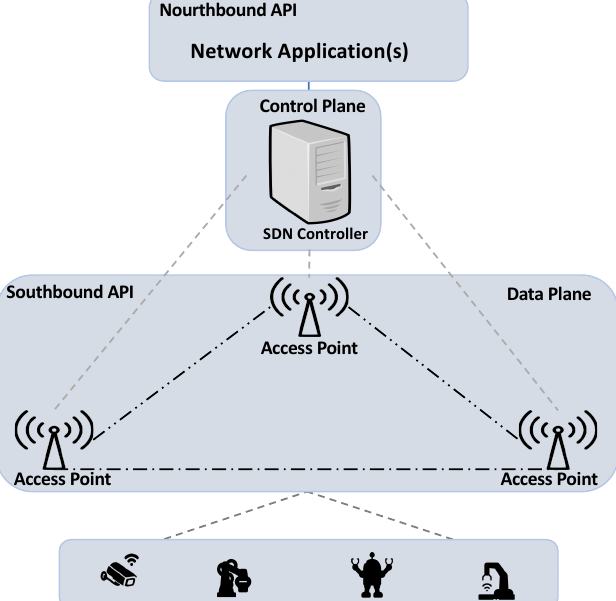
Figure 5. Components of the proposed SDN-based energy-aware routing